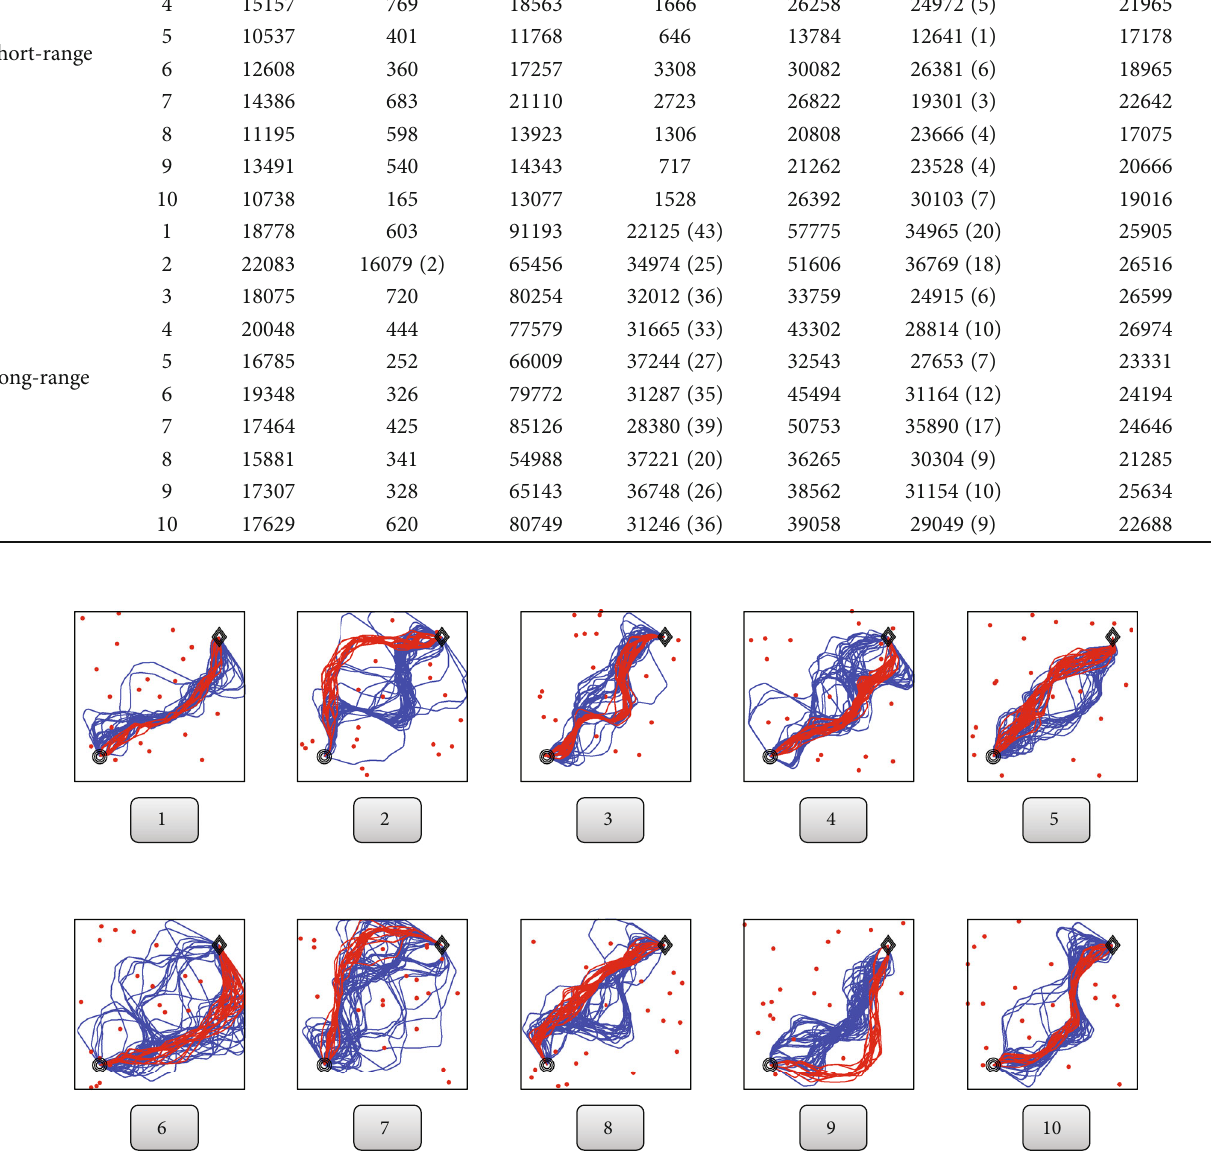
Figure 17: The paths of 50 Monte Carlo simulations at 200 iterations for short-range test cases. The blue lines and red lines represent the standard PSO results and the proposed PSO results,